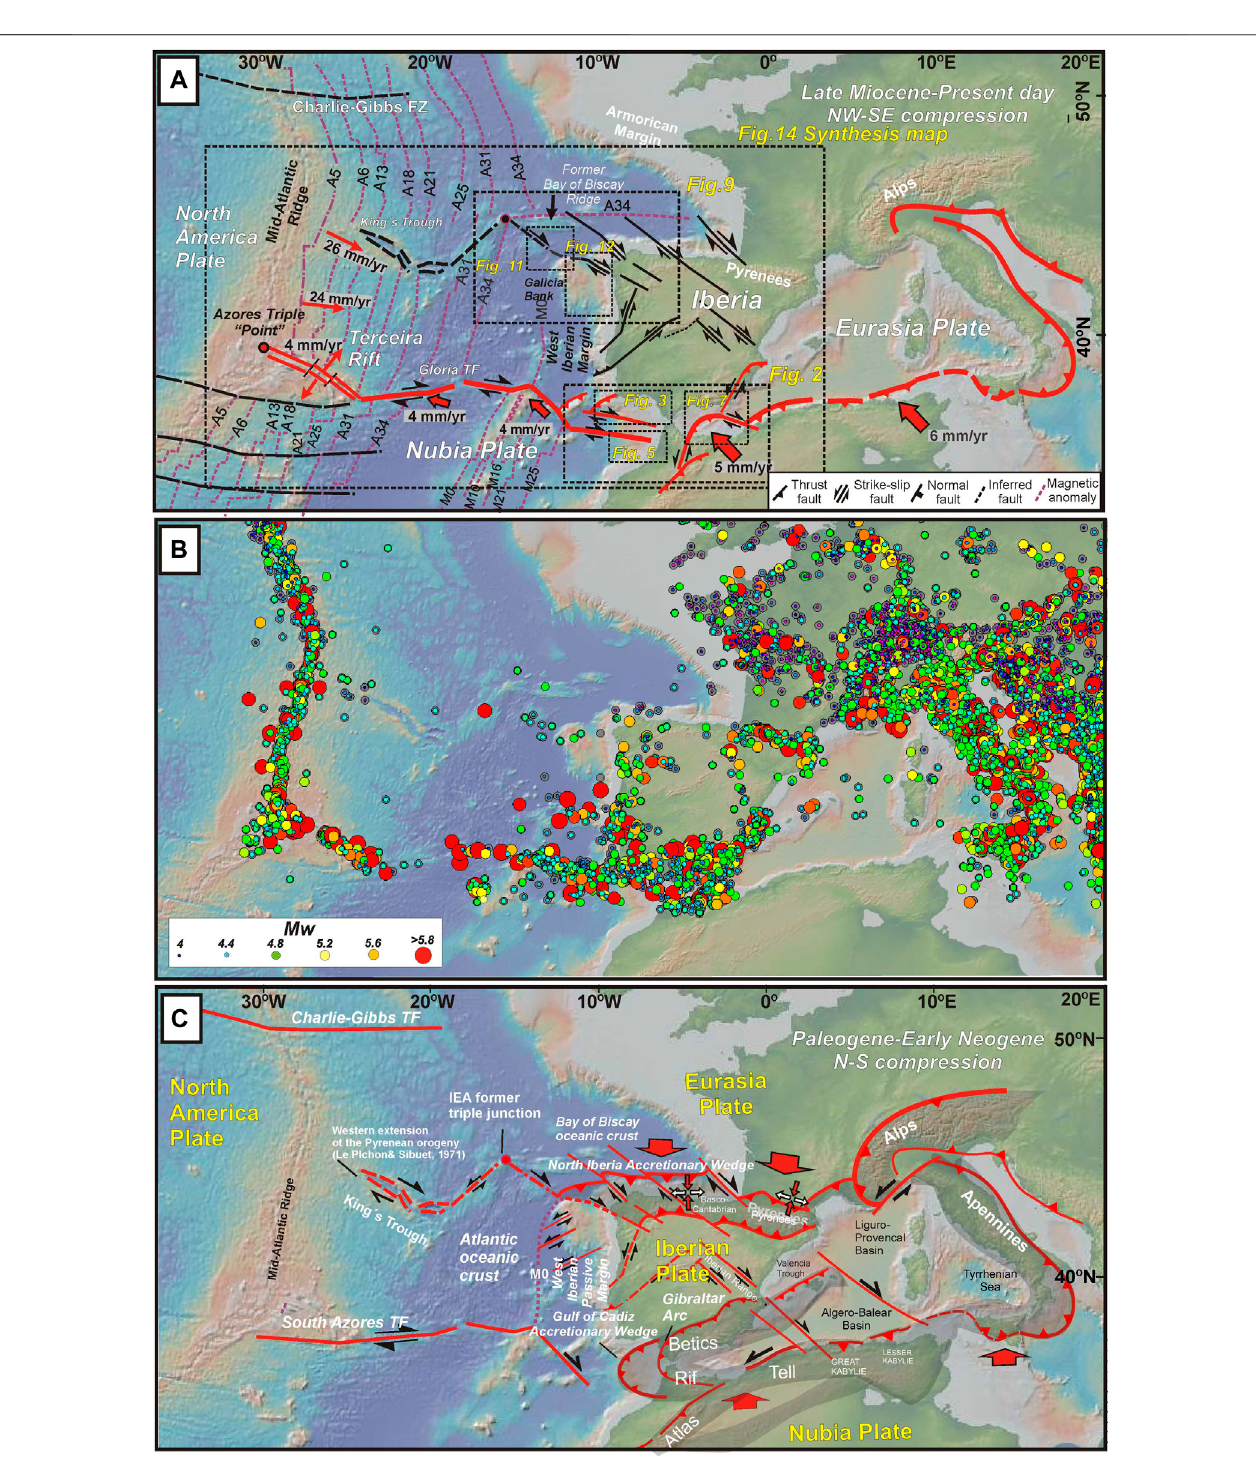
FIGURE1|(A) SummaryoftectonicstructuresaffectingtheIberianPeninsula.Offshoredatamodi fi edfromMaldonadoetal.(1999),Somozaetal.(2019).Onshore data comes from Vegas et al. (2008). Location of regional fi gures is also located. FZ: Fracture Zone. GoC: Gulf of Cádiz; GA: Gibraltar Arc; Alb: Alborán Sea. (B) DistributionofearthquakesofmagnitudeMw > 4aroundtheIberiaPeninsula.Source:SeismicHazardHarmonizationinEurope(SHARE),Giardinietal.(2013). (C) Alpine tectonic structures in Iberian in response to the convergence between Iberia, Africa, and Eurasia. Modi fi ed from Somoza et al. (2019); Terrinha et al., (2019), and Terrinha et al. (2020). Background bathymetry from http://www.geomapapp.org (Ryan et al., 2009).